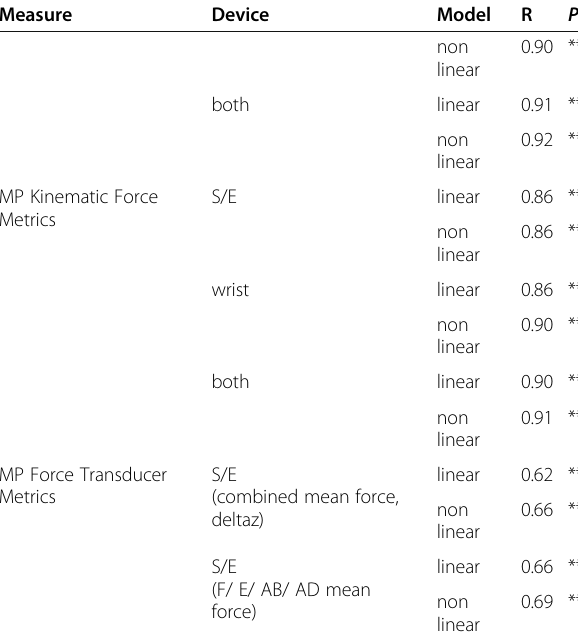
Table 3 Correlation of kinematic and kinetic metrics with clinical measures